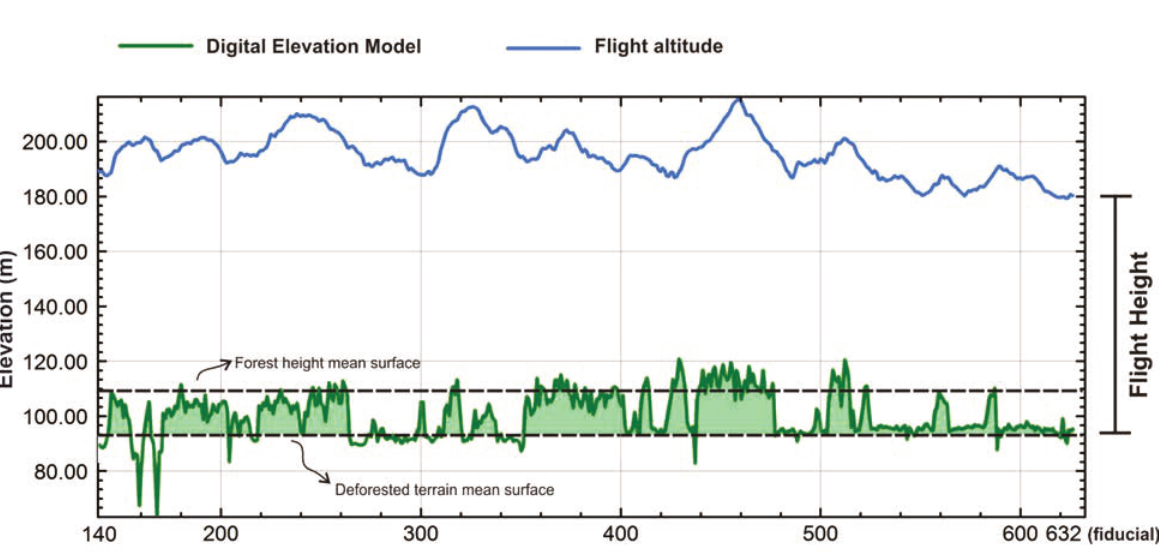
Figure 7 - Flight height compared to digital elevation model. The real distance between the source and the sensor is underestimated because the radar used in the common surveys considers the canopy tree as the ground